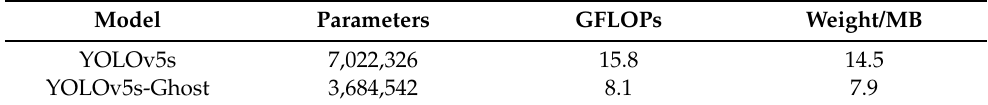
Table 2. Comparison results between YOLOv5s and